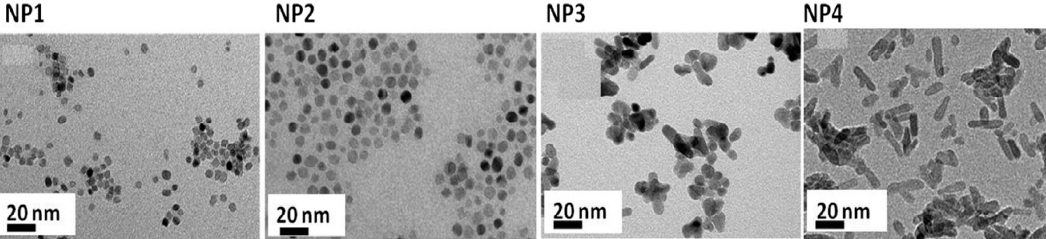
Figure 9. Transmission electron micrographs of solvothermally synthesized TiO 2 with nanospheres (NP1–NP2) and nanorods (NP3–NP4) morphologies. Reproduced with permission from [209].